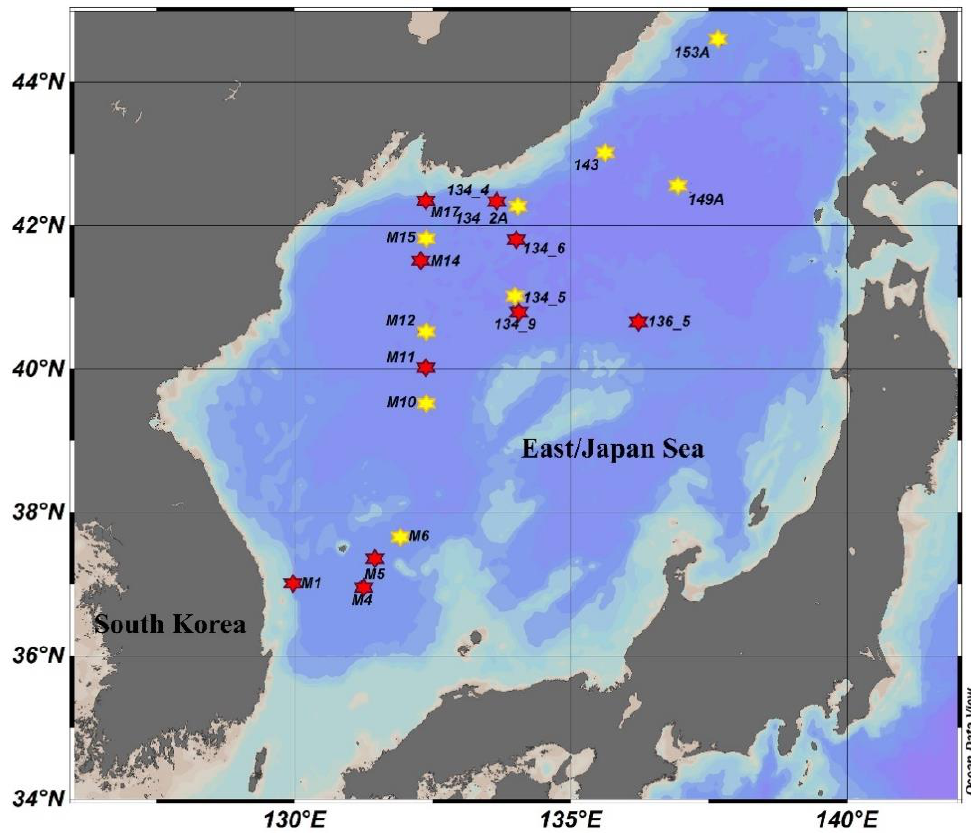
Figure 1. Sampling locations in the East / Japan Sea. The red stars indicate the sampling locations during 2012, and the yellow stars indicate the stations during the 2015 sampling.